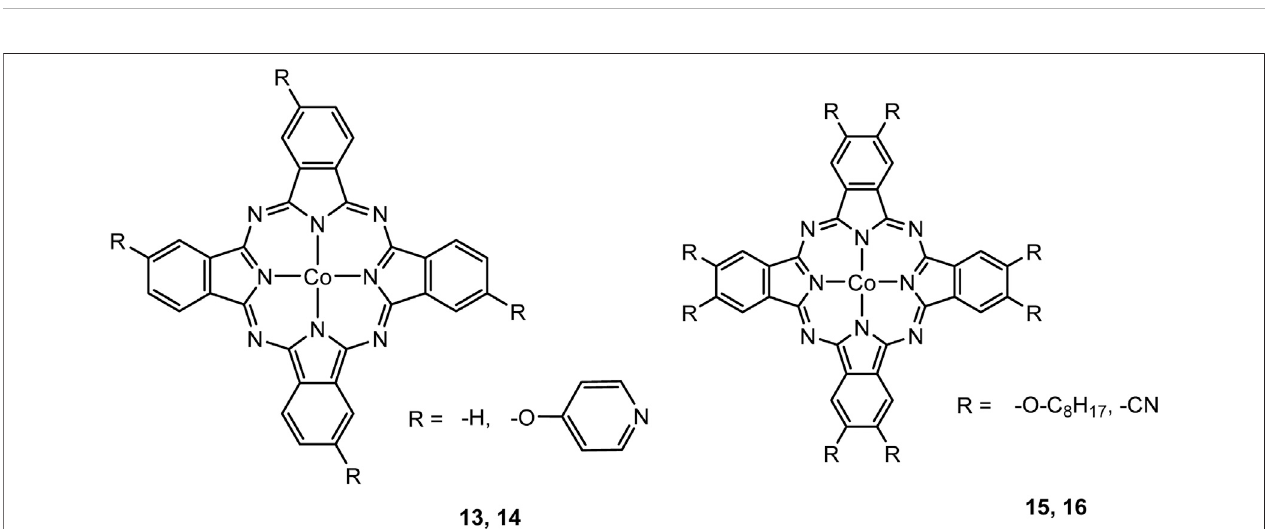
FIGURE 5 | Co − and Fe phthalocyanine complexes for CO 2 RR (Zhang et al., 2017b).